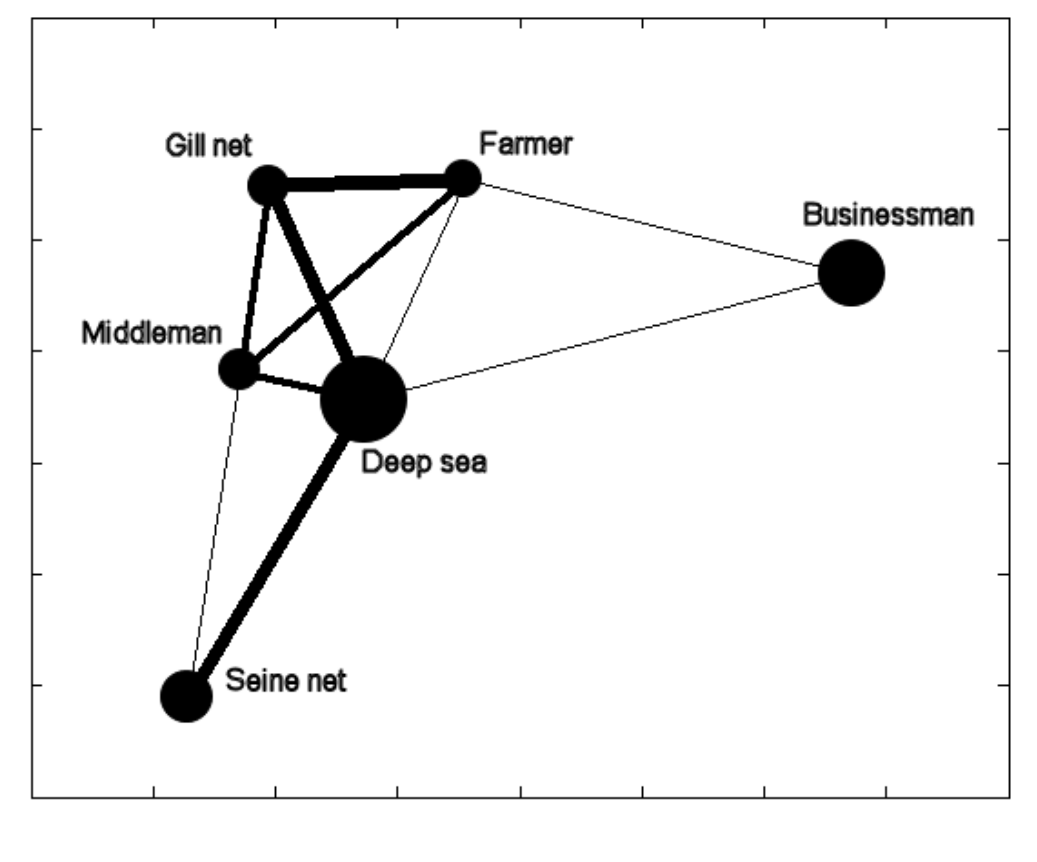
Fig. 3. Multidimensional scaling plot showing the social network structure of relations among groups based on predefined occupational categories. The size of each node is proportional to the group size, and the thickness of the links is proportional to the strength of the intergroup relations, i.e., the ratio of the observed vs. the expected number of relations. Thin line < 0.5, medium line < 1, thick line > 1. Worth noting is that no direct exchange between fisher categories Seine net and Gill net